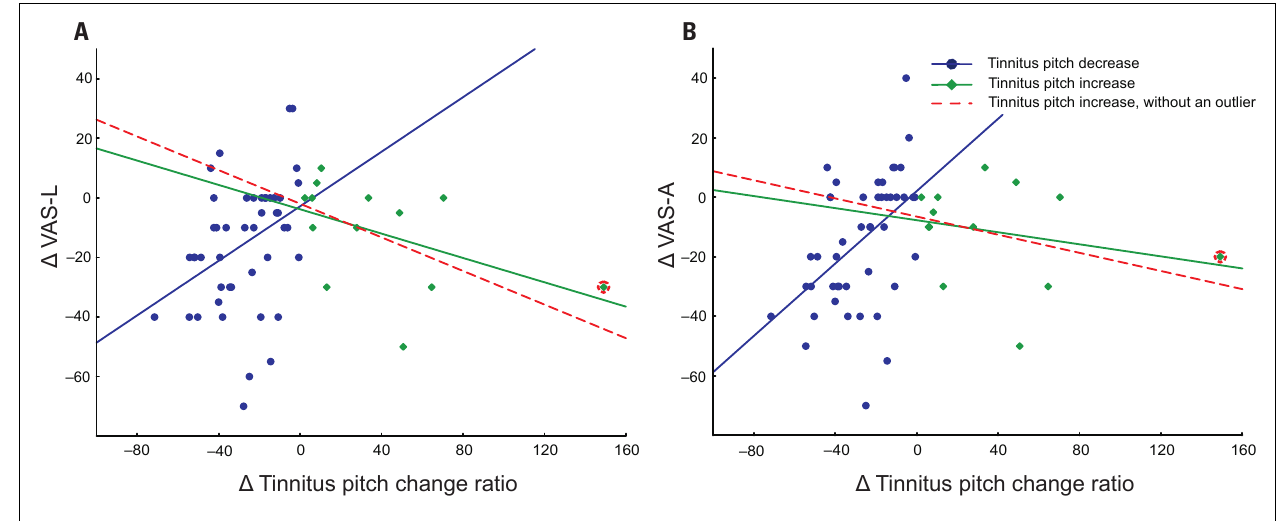
FIGURE 1 | Changes inVAS-L (A) andVAS-A (B) as a function of a tinnitus pitch change ratio. Patients are divided into two groups: (1) tinnitus pitch decrease (blue, n = 46); (2) tinnitus pitch increase (green, n = 13 or red dashed line after removal of an outlier, n = 12). An outlier patient is marked by the red circle.